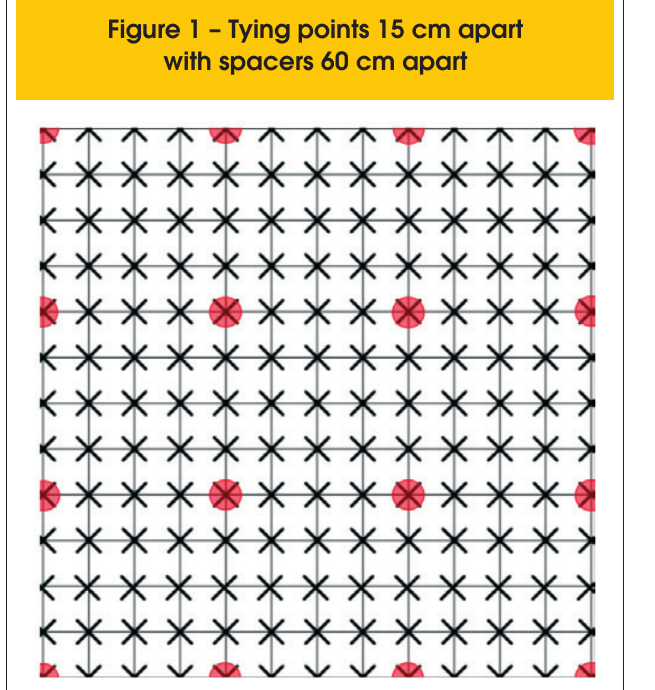
Figure 2 – Tying points 30 cm apart with spacers 60 cm